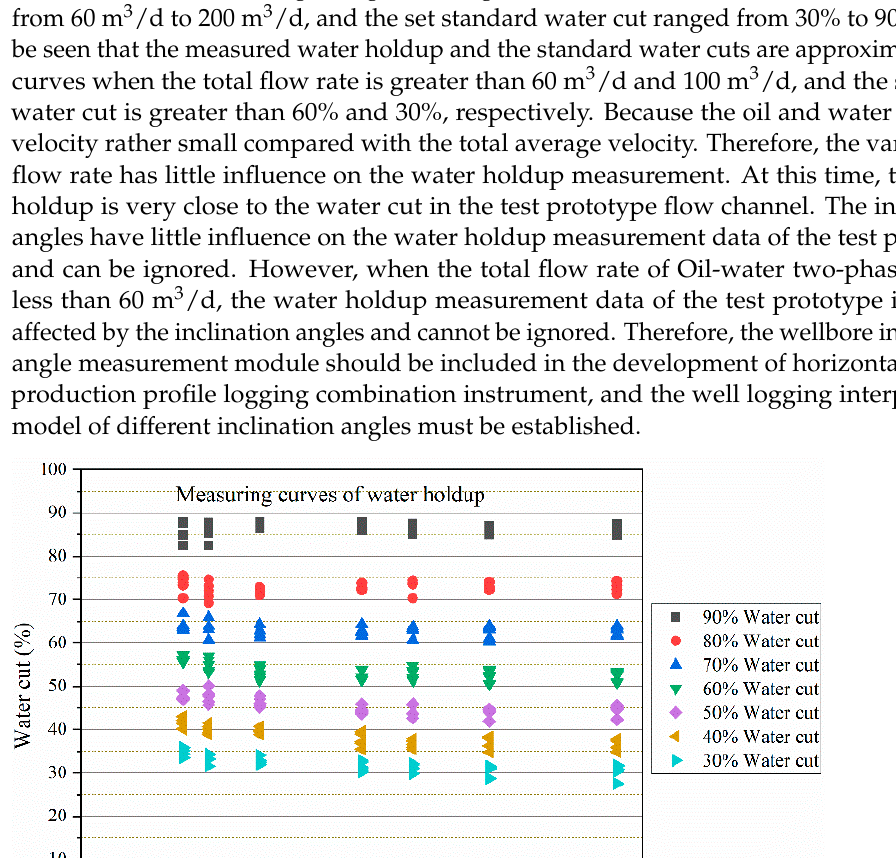
Figure 9. Water holdup measurement chart (inclination angle 90 ◦ ).